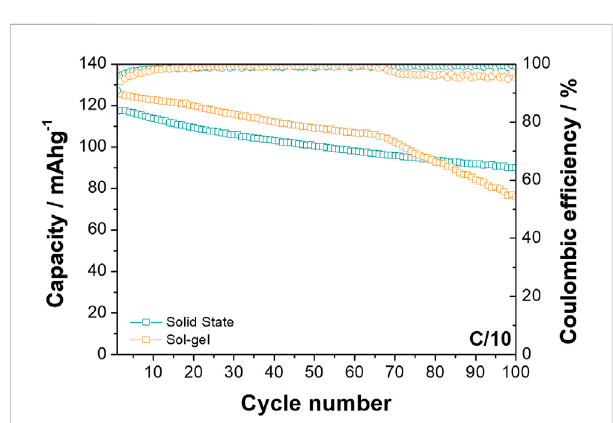
FIGURE 3 Cyclability plots of O3-NaNMFO-SS (dark turquoise) and O3- NaNMFO-SG (orange) at C/10.